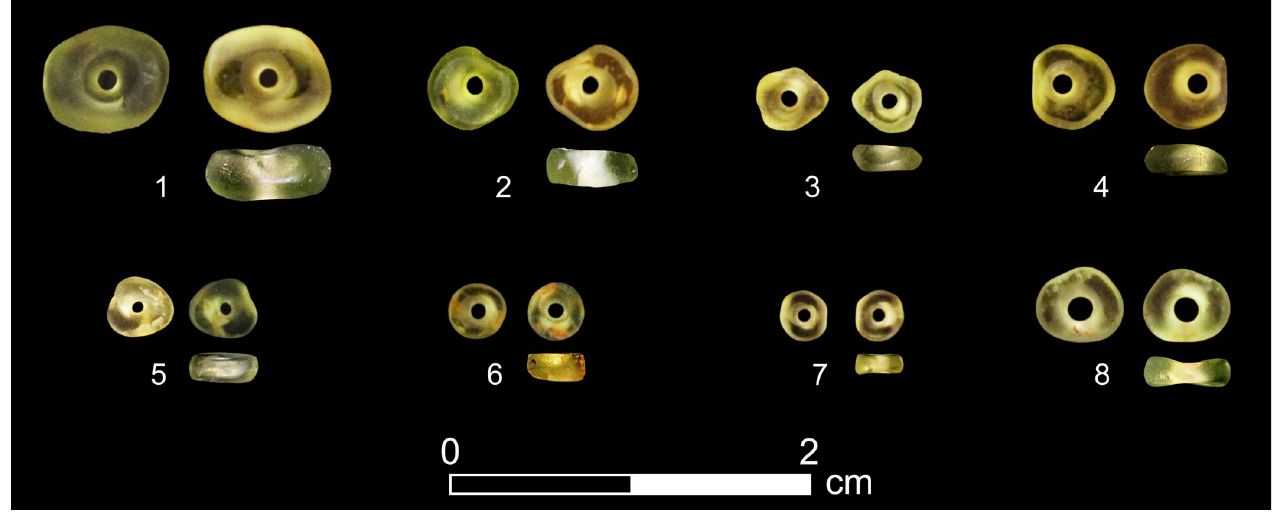
Fig 3. The Tel Tsaf olivine beads.